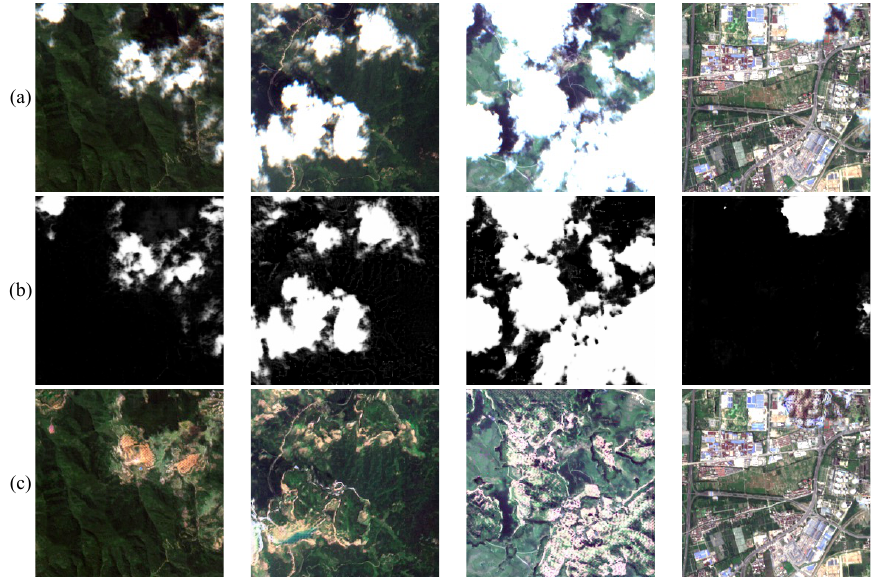
Figure 8. Failed example results of our method on Sentinel-2A image patches at 256×256 resolution. (a) Input image. (b) attention map. (c) Generated cloud-free